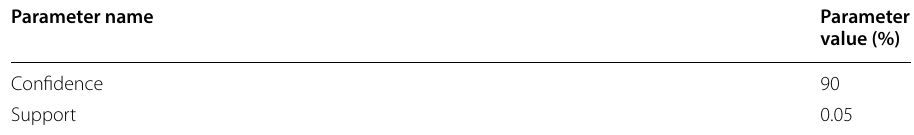
Table 15 Association rule parameters